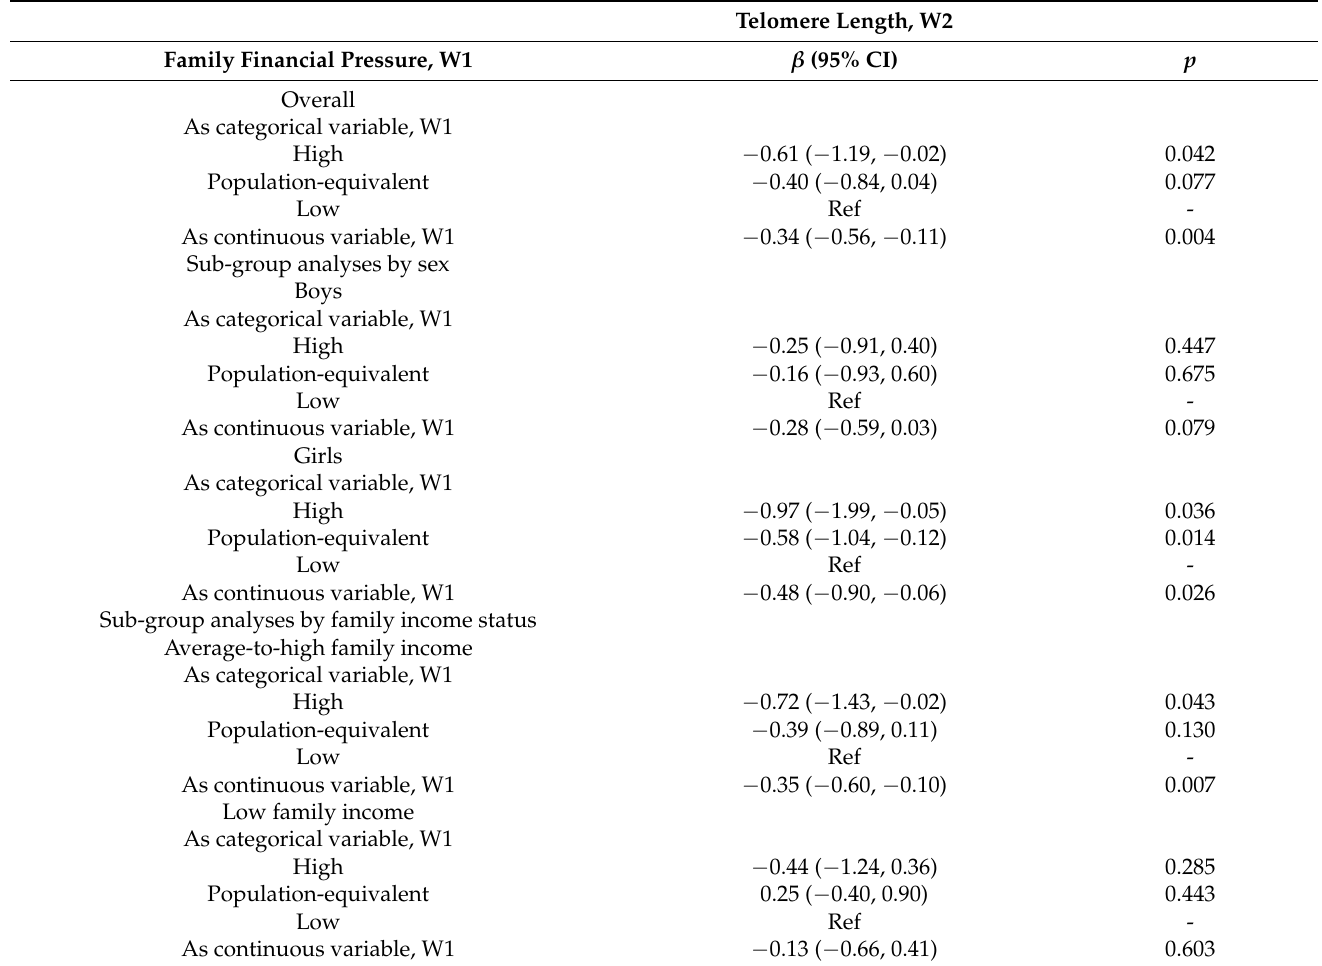
Table 3. Associations between early-life exposure to family financial pressure and telomere length in early